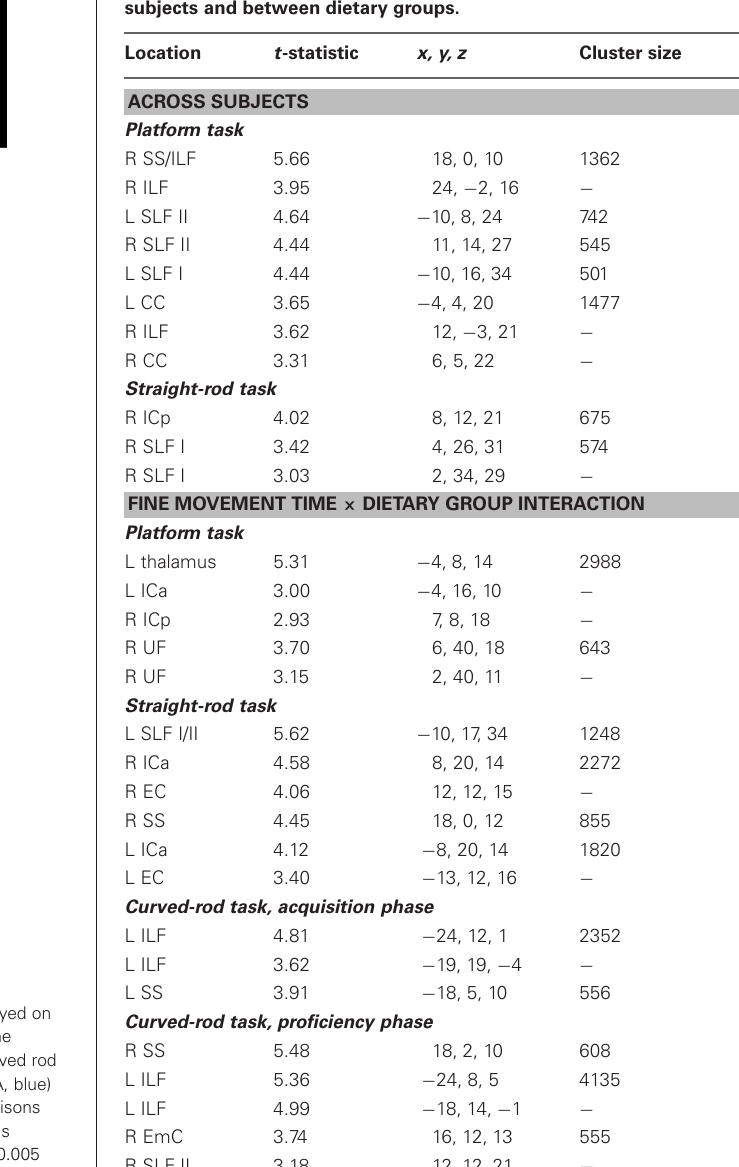
− Notes: L, left; R, right; SS, sagittal stratum; ILF, inferior longitudinal fasciculus; SLF, superior longitudinal fasciculus; CC, corpus callosum; ICa, internal capsule, anterior limb; ICp, internal capsule, posterior limb; UF, uncinate fasciculus; EC, external capsule; EmC, extreme capsule; CP, cerebral peduncle. Only clusters with 500 or more voxels are reported here; refer to Appendix for complete